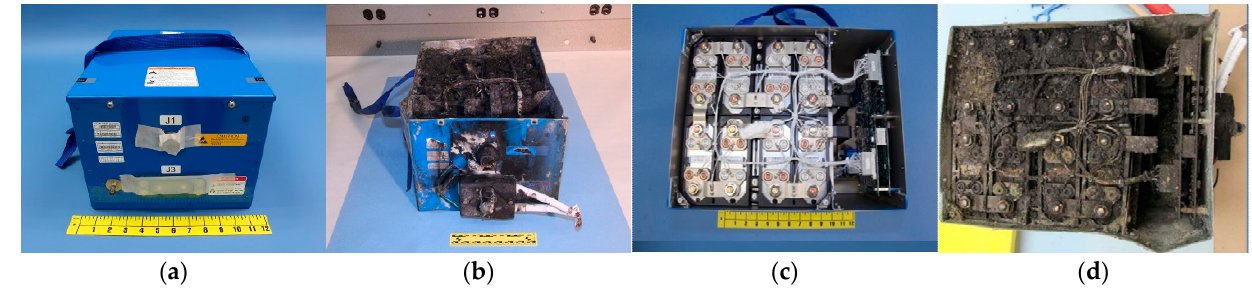
Figure 6. Boeing 787 APU block [54]: ( a , c ) Exemplar block; ( b , d ) The rest after 2013 accident.